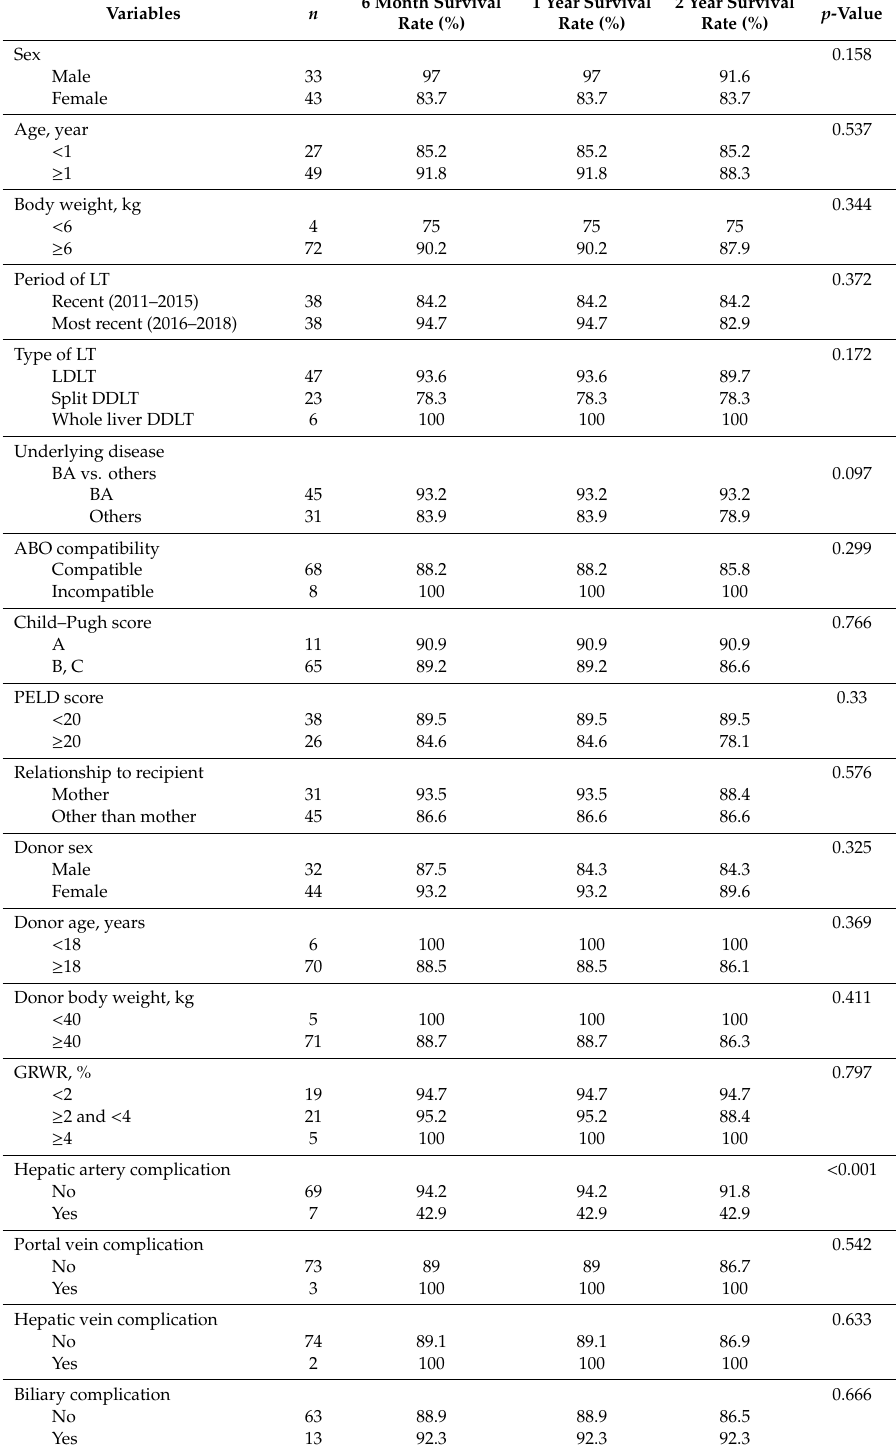
Table 3. Univariate analysis of factors associated with patient survival using the KOTRY